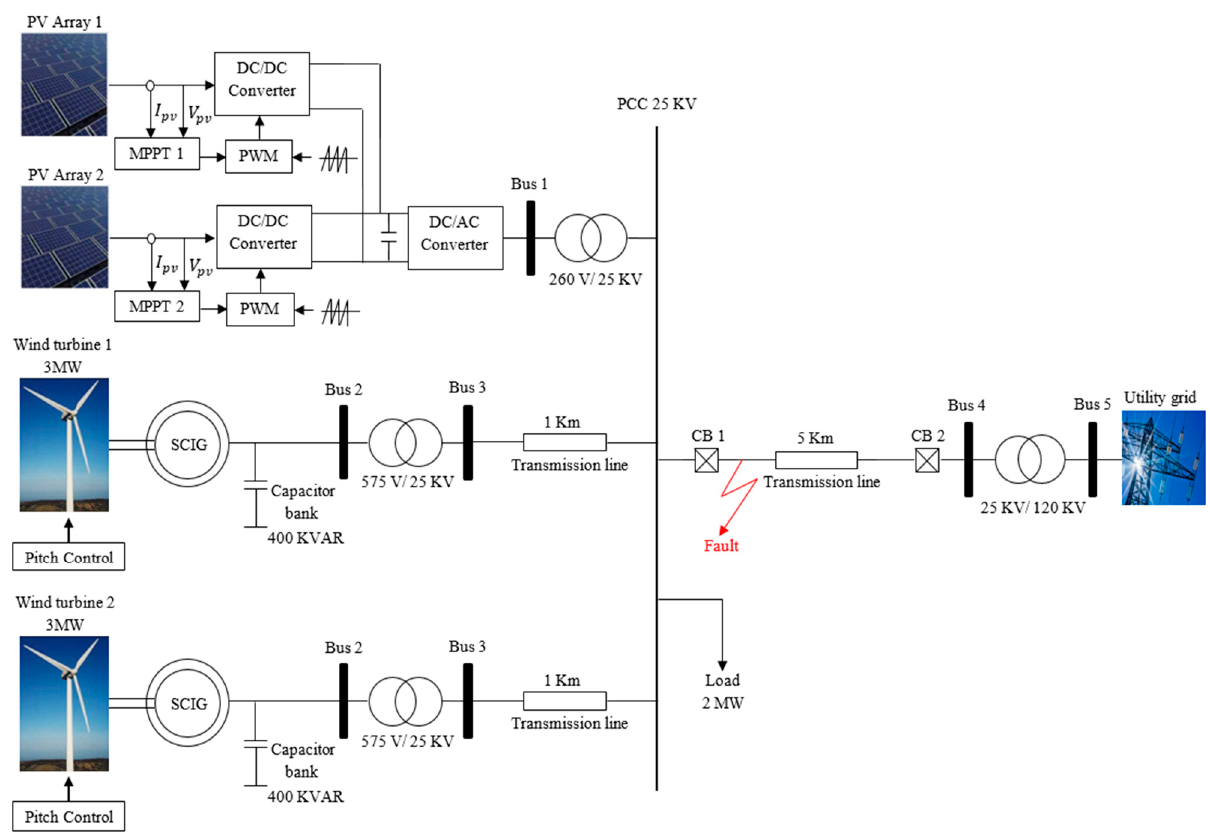
Figure 1. Architecture for hybrid systems.